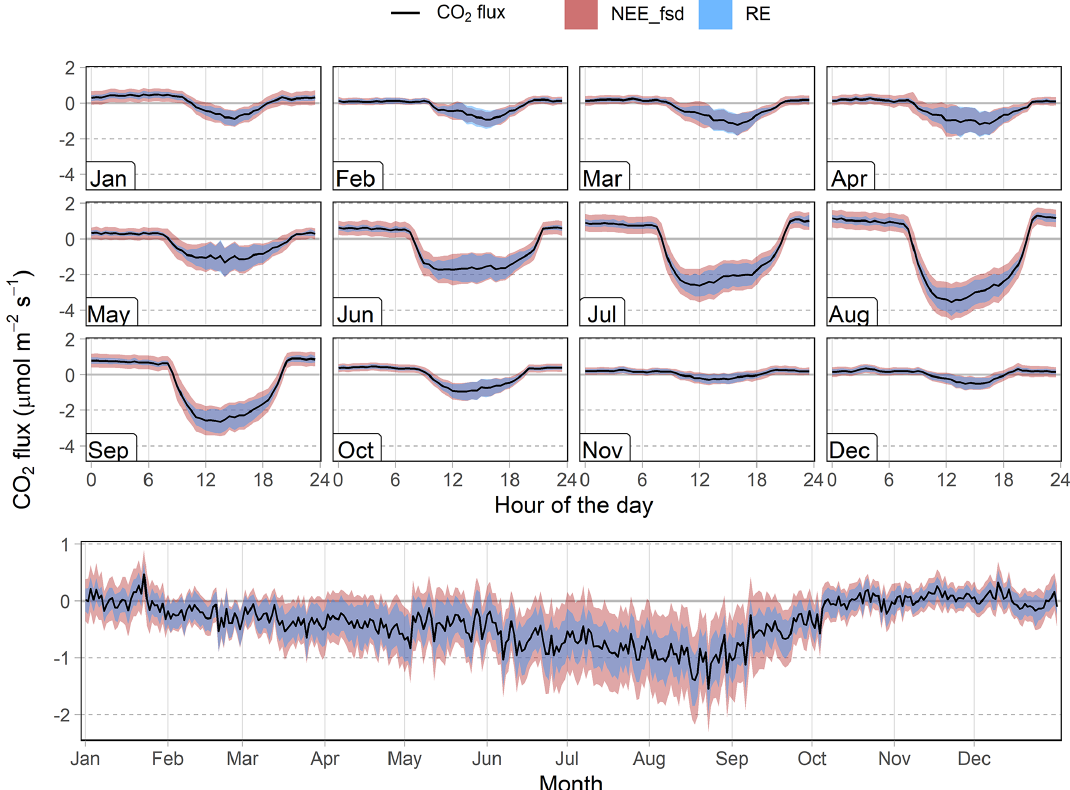
Figure 8. Monthly mean diurnal course and annual course of the daily mean of the CO 2 fluxes and uncertainty estimates. RE is the random uncertainty following Finkelstein and Sims (2001), and NEE_fsd is the standard deviation of values used for gap filling after Reichstein et al.